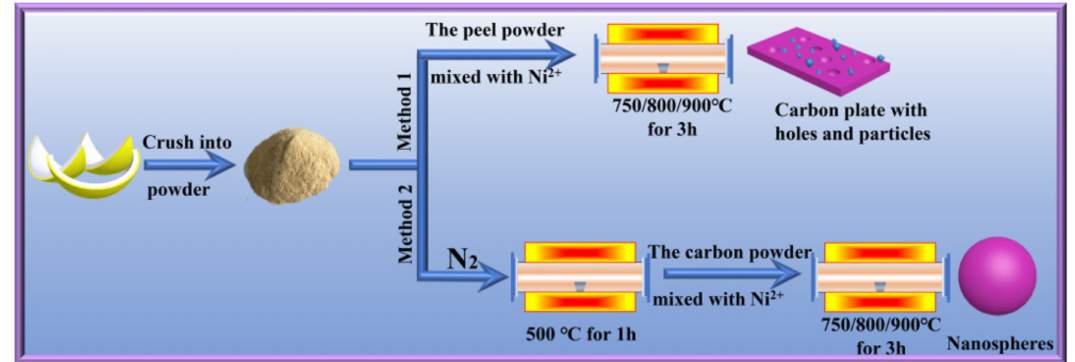
Figure 1. Schematic flow diagram of the traditional method and the improved